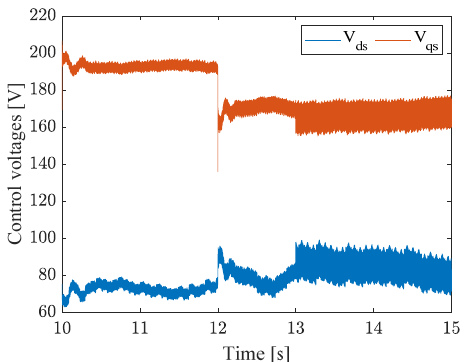
Figure 12. dq control voltages with PI controller in healthy and faulty modes.